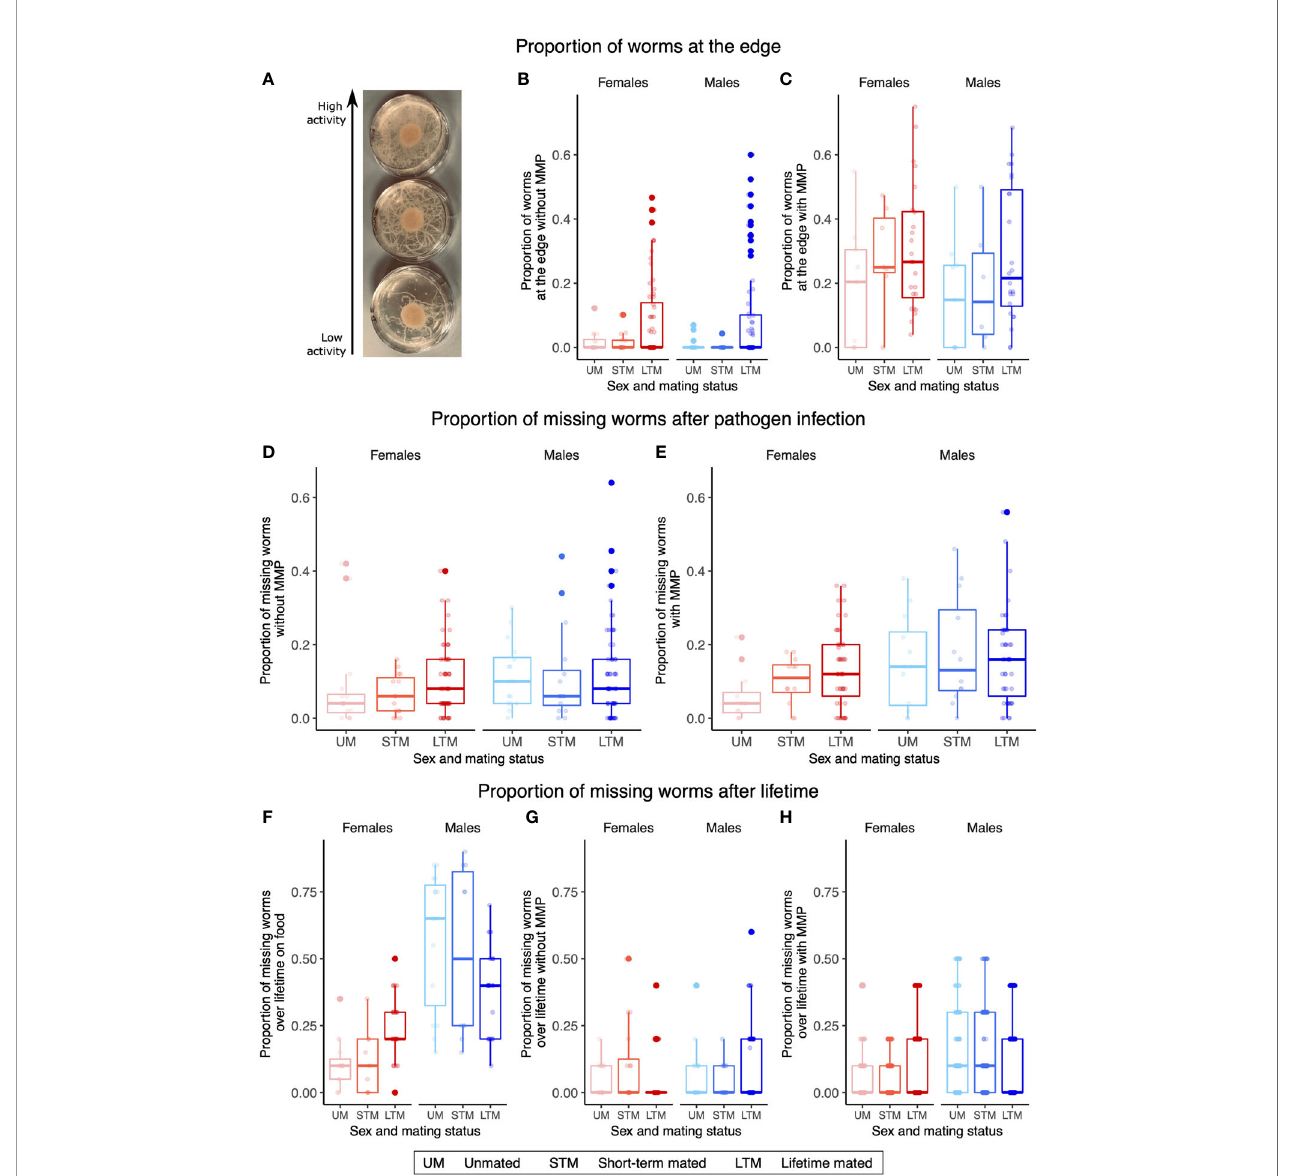
FIGURE 2 | Female and male behavior is linked to the presence of the other sex. (A) Picture of three pathogenic plates with different activity levels from low to high. (B) Without MMP after pathogen infection, plates with lifetime mated worms of both sexes had a higher proportion of worms at the edge of the plate. (C) With MMP after pathogen infection, plates with lifetime mated worms of both sexes have a higher proportion of worms at the edge of the plate. Proportion of missing worms of different sexes and mating treatments either during pathogen infection (D, E) and over lifetime ( F – H , only the last time point is plotted). (D) During pathogen infection without MMP, a higher proportion of males are missing than of females. (E) During pathogen infection with MMP, more males went missing than females. (F) Proportion of missing worms on food over lifetime. Females showed lower proportion of missing worms than males. (G) Proportion of missing worms without MMP over lifetime with no differences detected. (H) Proportion of missing worms with MMP over lifetime, where males have a higher proportion of missing worms than females do. (B – H) Boxplots represent the mean ± the standard error of the mean of four or fi ve biological replicates and three or four technical replicates with 50 (B – E) , 20 (F) , or 10 worms (G, H) on each plate. (F – H) Changes in the proportion of missing worms over time can be found in Figure S2